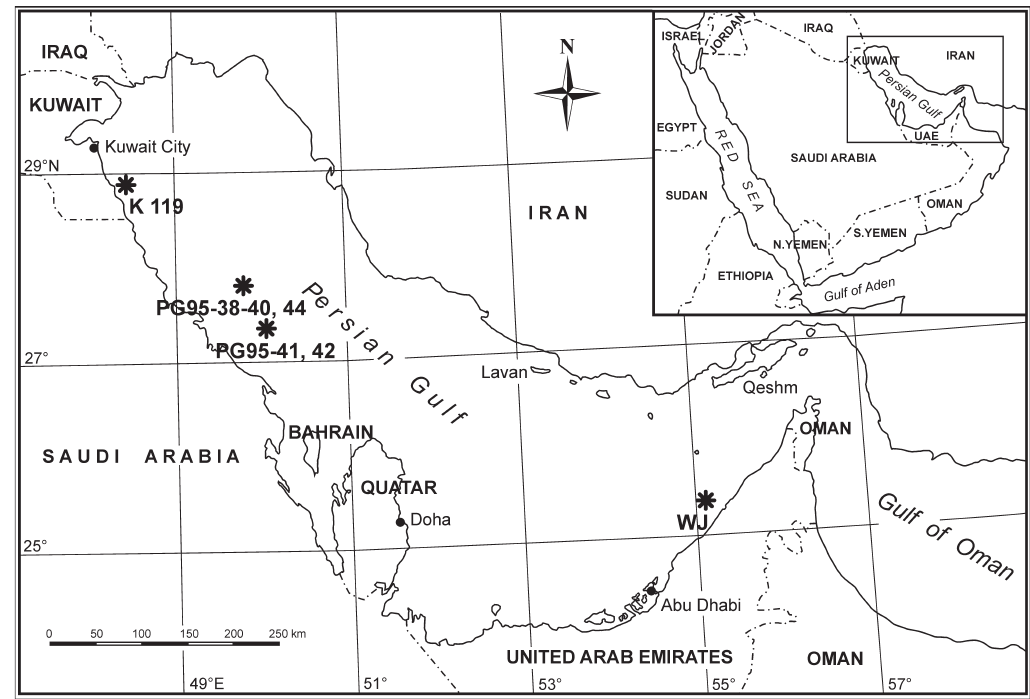
Fig . 1. – Map of the Persian gulf, showing the location of the samples where brachiopods were found; WJ – approximate position of Jackson’s collecting